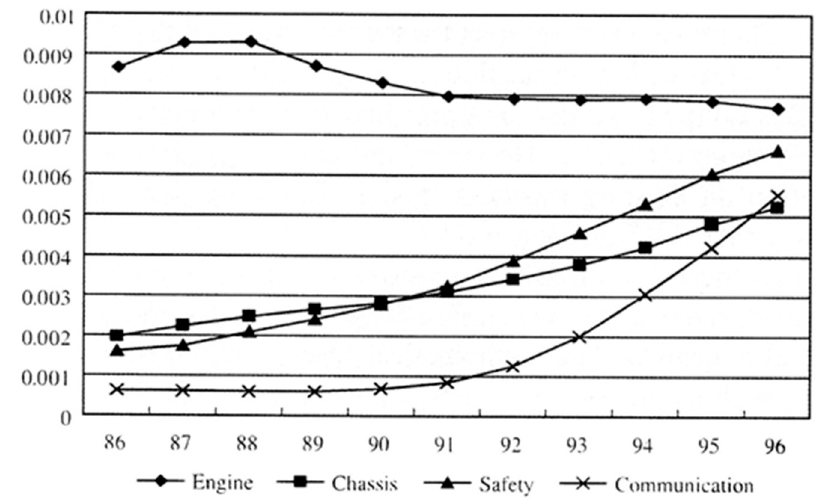
Figure 5. The weight of electronic control unit (ECU) in each category of automobile control systems. Source: Ogawa, H. (2000) [18].